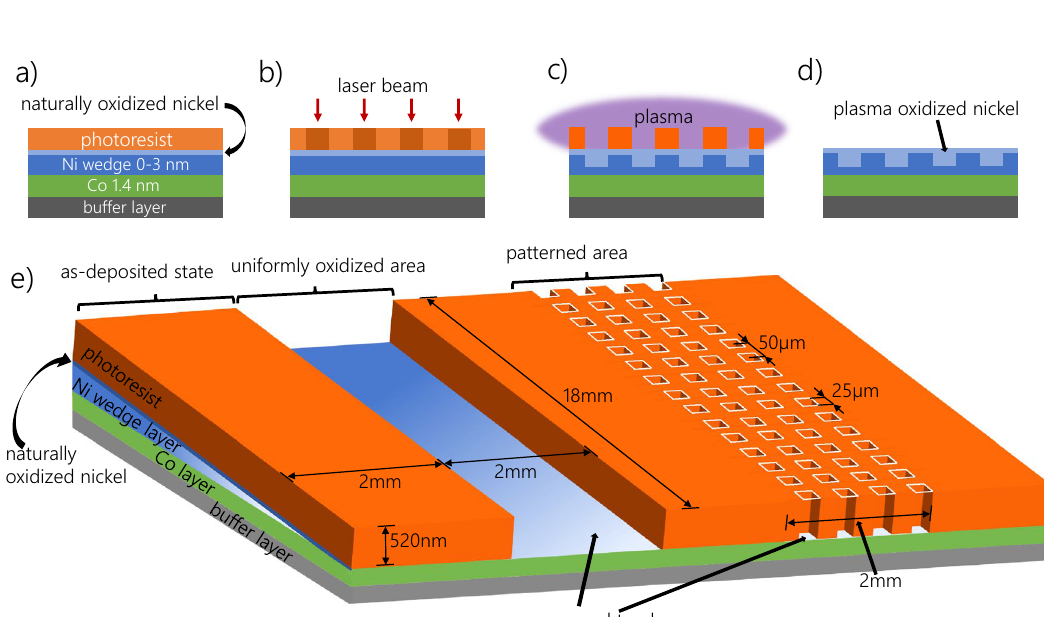
Figure 3. Scheme of magnetic patterning process of Co/Ni system ( a ) that incorporates photolithography ( b ) and PO treatment ( c ). Final state of the sample is shown on ( d ). In panel ( e ) the design of the mask with all important information is